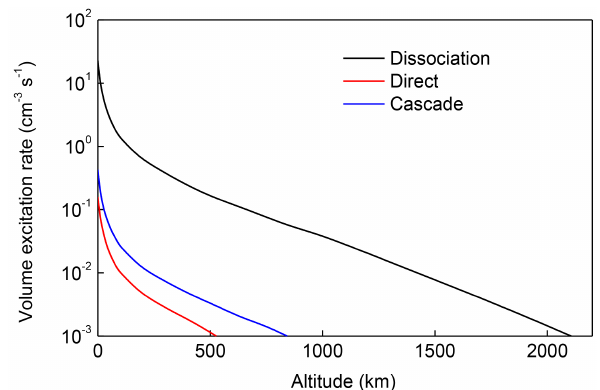
Figure 6. OI 1356Å intensity in Rayleigh ( R ) versus electron tem- perature ( T h ) for the Maxwellian distribution (Eq. 20). Whistler wave amplitude is indicated.